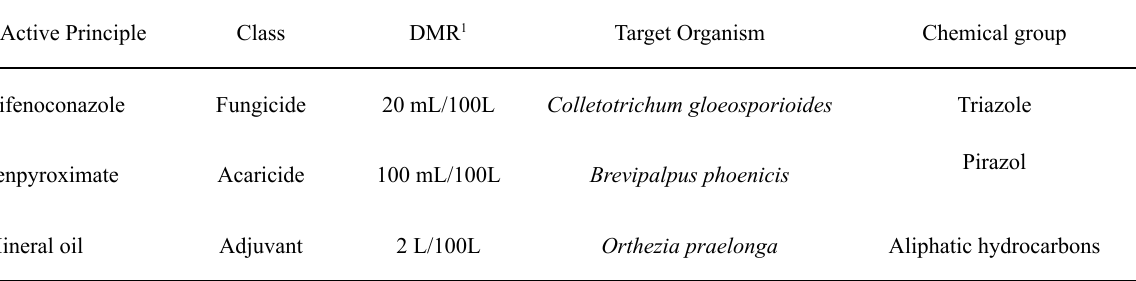
Table 1 . Active principle, class, maximum dosages recommended by the manufacturer (DMR), target organism and chemical group of pesticides used in citrus